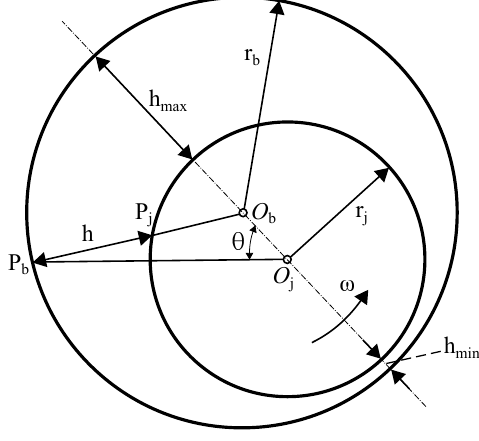
Figure 1: Geometry of journal